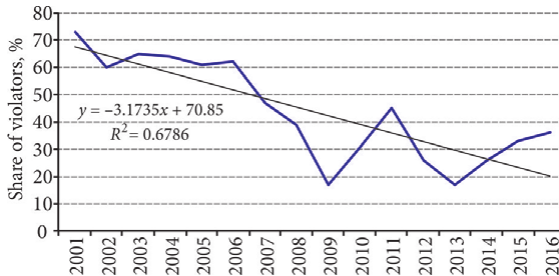
Fig. 4. Yielding to pedestrians at uncontrolled crossings in Estonia